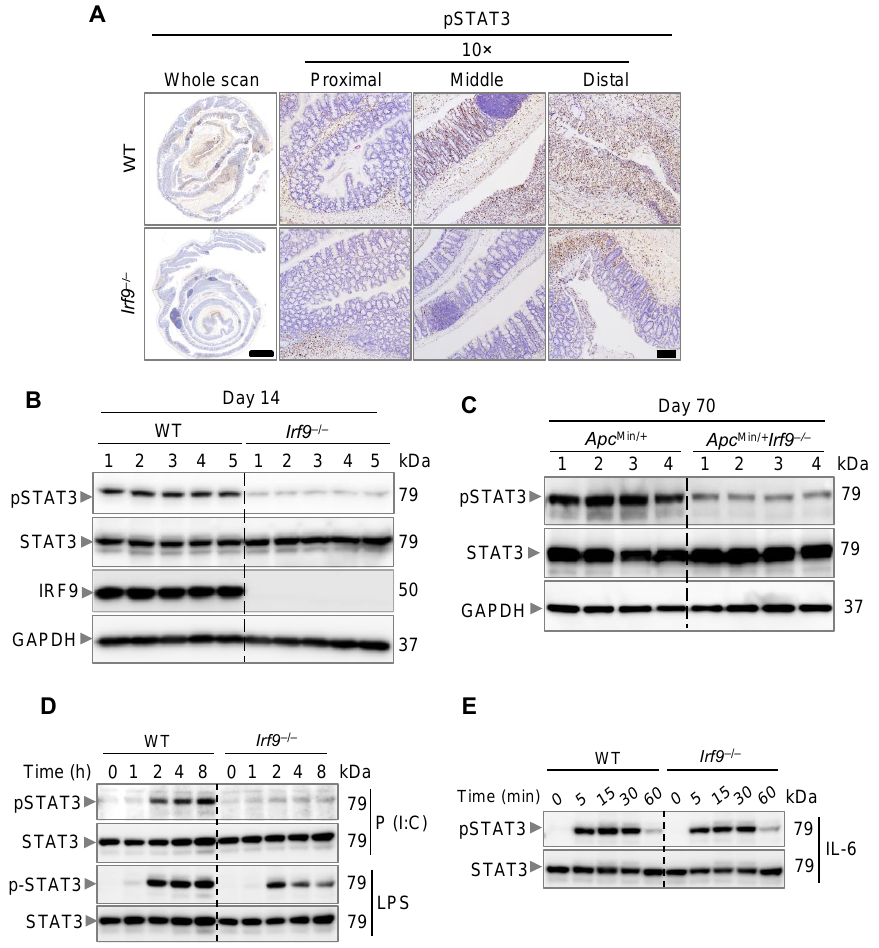
Figure 5. IRF9 drives STAT3 activation. ( A ) Representative images of pSTAT3 staining of colon tissues from AOM/DSS-treated wild type (WT) and Irf9 –/– mice 14 days after AOM injection. Tissues were counterstained with hematoxylin. ( B ) Immunoblot analysis of phosphorylated and total STAT3 (pSTAT3 and STAT3, respectively) and IRF9 in the colon of WT and Irf9 –/– mice 14 days after AOM injection. Each lane corresponds to an individual mouse. ( C ) Immunoblot analysis of pSTAT3 and STAT3 in the colon of Apc Min/+ and Apc Min/+ Irf9 –/– mice at day 70. Each lane corresponds to an individual mouse. ( D ) Immunoblot analysis of pSTAT3 and STAT3 in WT and Irf9 –/– bone marrow-derived macrophages (BMDMs) stimulated with poly(I:C) (P (I:C)) or LPS for the indicated time. ( E ) Immunoblot analysis of pSTAT3 and STAT3 in WT and Irf9 –/– BMDMs stimulated with IL-6 for the indicated time. Scale bar, 2 mm for whole scan and 500 μm for proximal, distal, and middle colon.